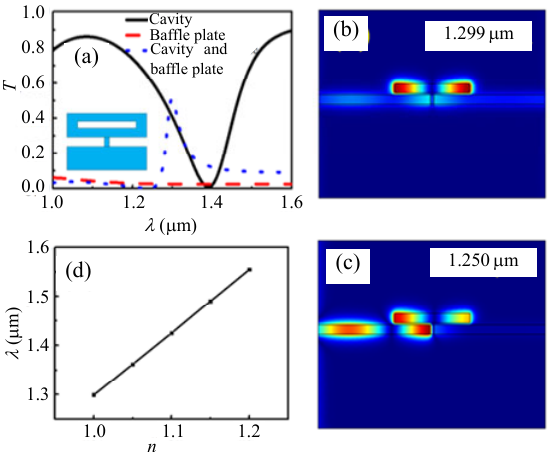
Fig. 3 Simulation results, where only rectangular cavity A is considered: (a) transmission spectra of the side-coupled resonator systems, (b) and (c) the field distributions of | H z | at the transmitted peak (1299 nm) and dip (1250 nm), respectively, and (d) the wavelength of the Fano resonance peak as a function of the refractive index.